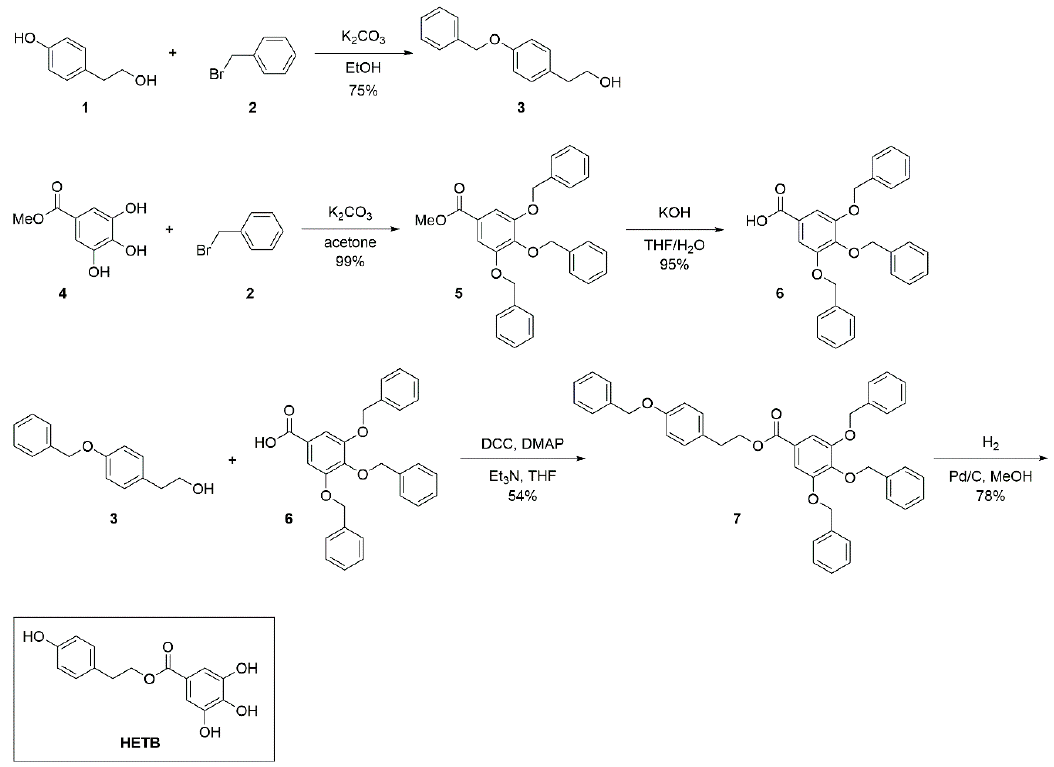
Figure 1. Chemical synthesis of 2-(4-hydroxyphenyl)ethyl 3,4,5-trihydroxybenzoate (HETB).